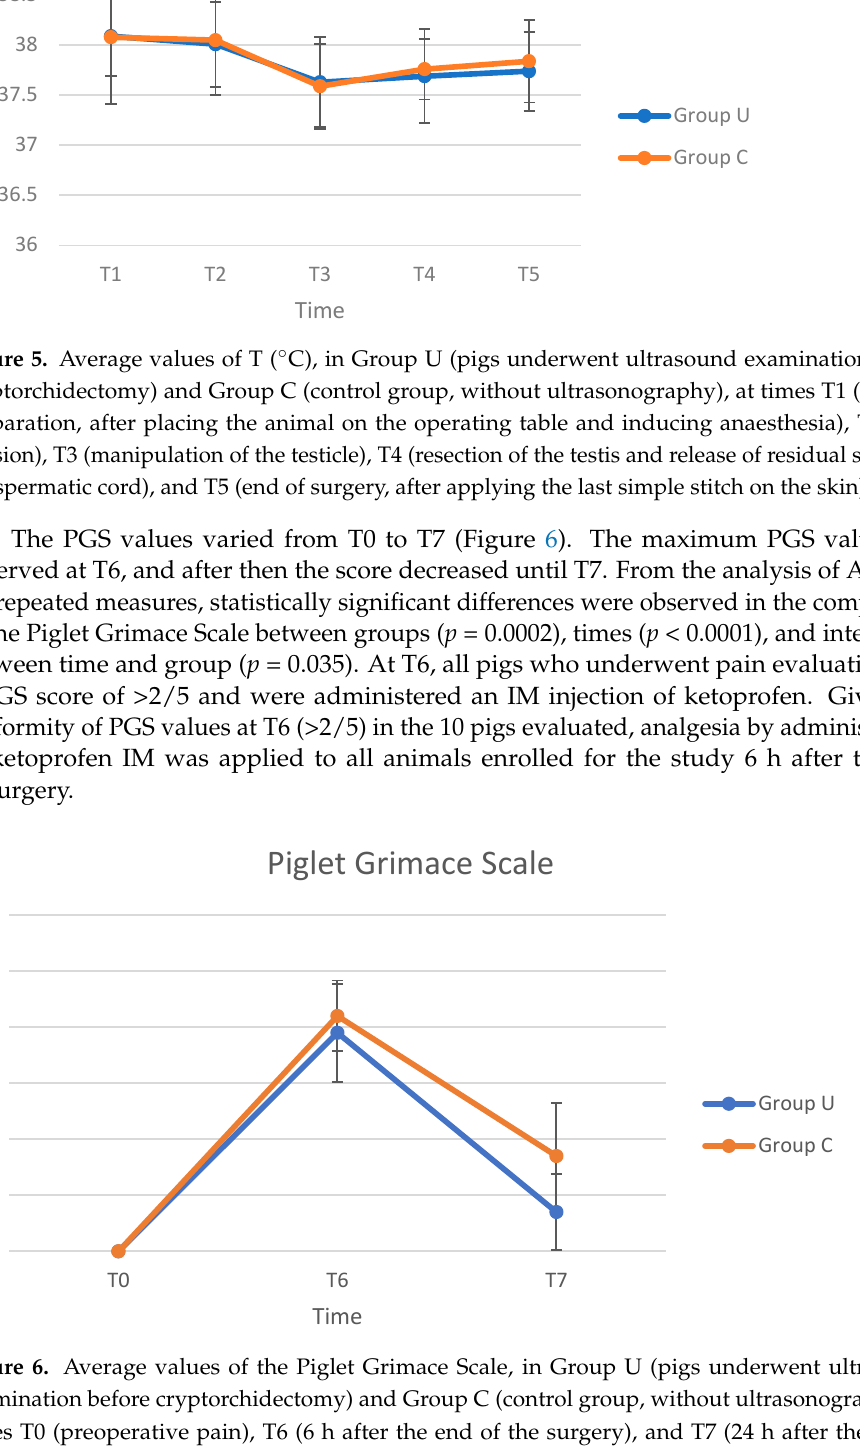
Figure 6. Average values of the Piglet Grimace Scale, in Group U (pigs underwent ultrasound examination before cryptorchidectomy) and Group C (control group, without ultrasonography), at times T0 (preoperative pain), T6 (6 h after the end of the surgery), and T7 (24 h after the end of the surgery).